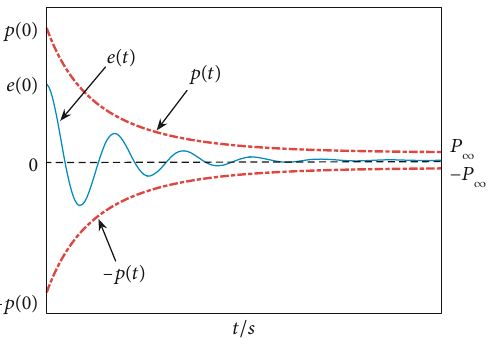
Figure 2: Prescribed performance de fi ned by Equation